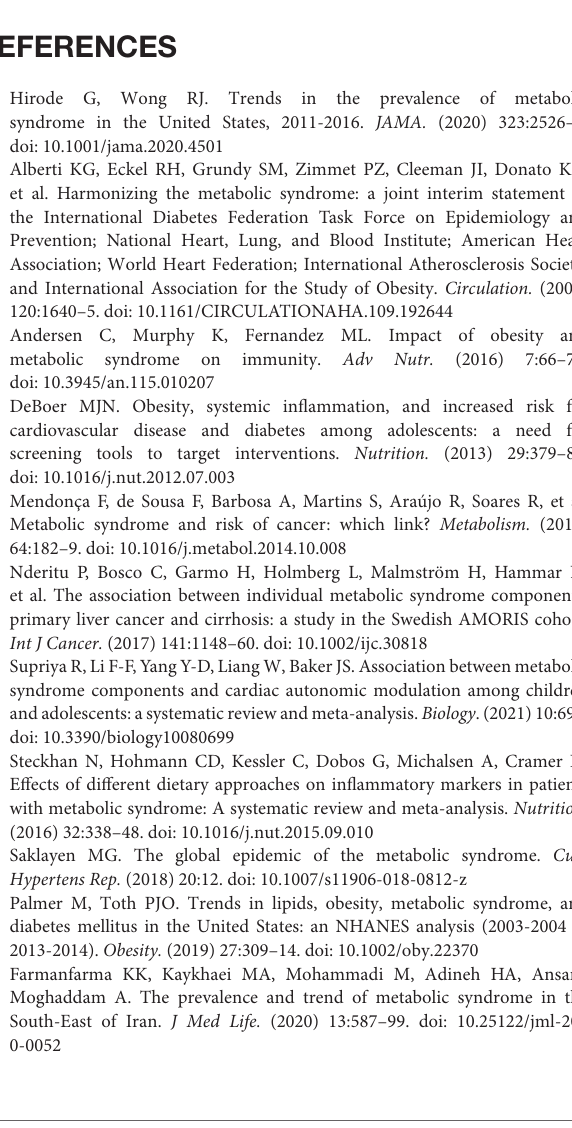
Supplementary Table 3 | Assessment of the quality of seven cohort studies and one case-control study by Newcastle-Ottawa Scale (NOS). Supplementary Table 4 | Assessment of the quality of one randomized controlled trial by Cochrane Scale. Supplementary Table 5 | Begg’s test and Egger’s test of the included studies in the meta-analysis. Supplementary Table 6 | Meta-regression models of multivariable-adjusted analyses. Supplementary Figure 1 | Begg’s funnel plots of the included studies in the meta-analysis. (Only when the number of included studies was more than five, the Begg’s test and plot were conducted. MetS, metabolic syndrome; BP, blood pressure; FPG, fasting plasma glucose; TG, triglycerides; HDL, high-density lipoprotein). Supplementary Figure 2 | Sensitivity analysis of the included studies in the meta-analysis. (The slow eating group was used as the reference group.